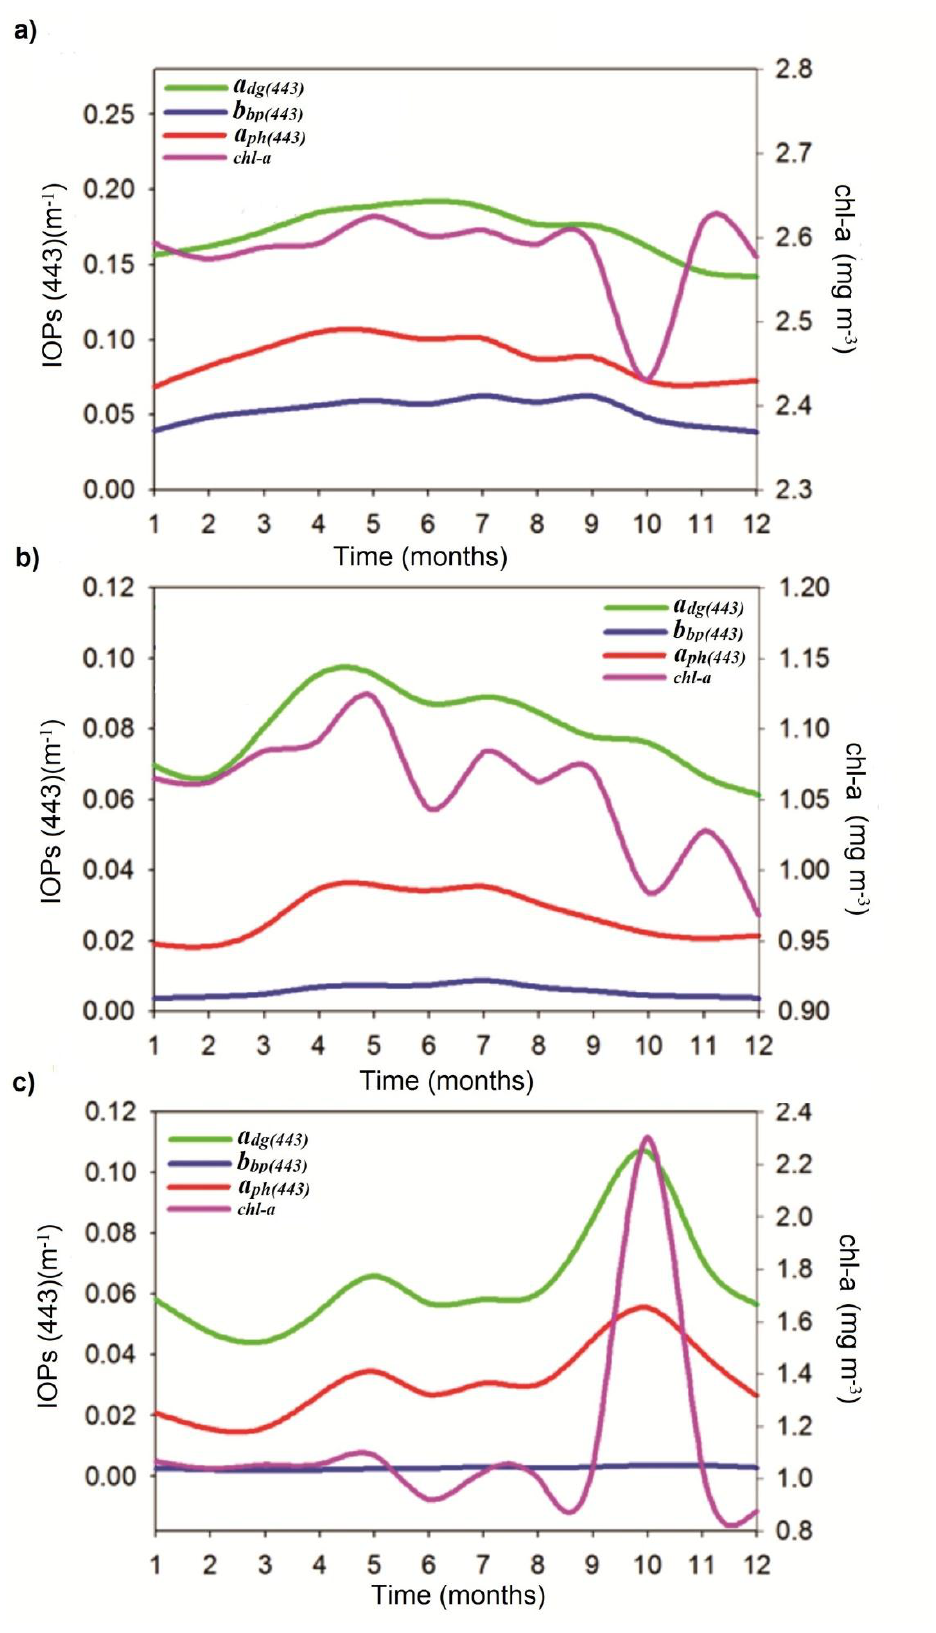
Figure 5. Climatology of the bio-optical parameters in the ( a ) coastal zone; ( b ) the inner-shelf, and ( c ) the